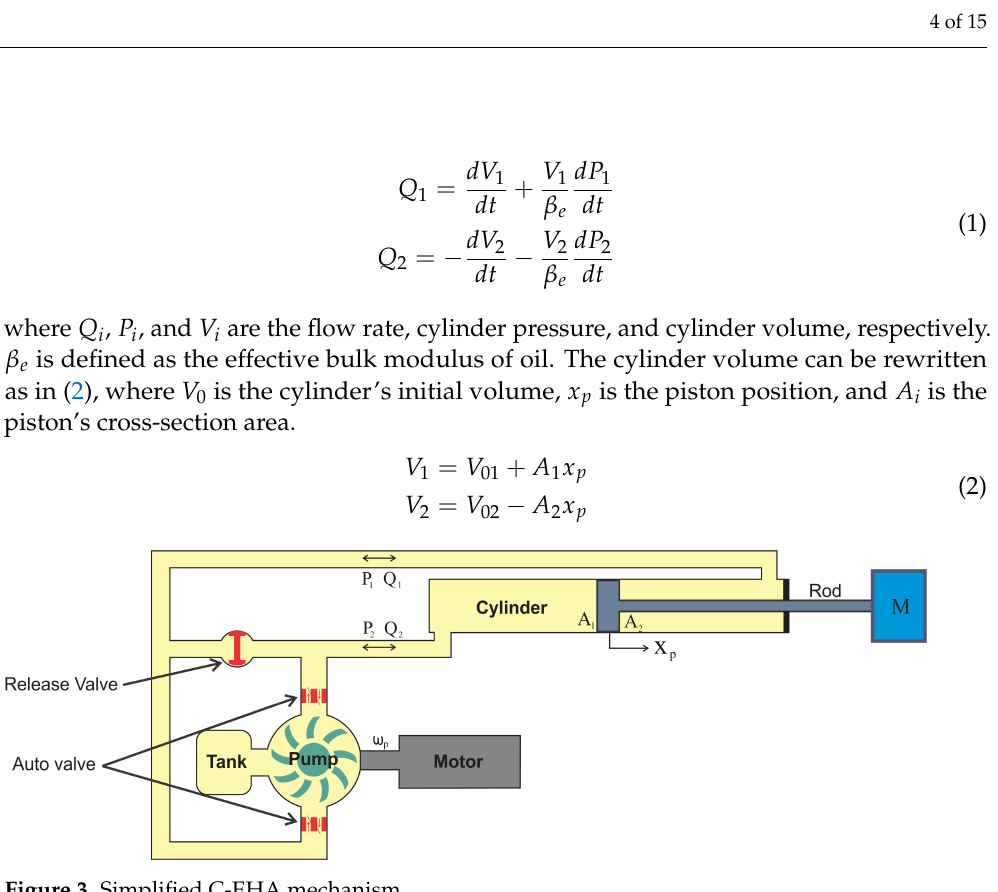
Figure 3. Simplified C-EHA